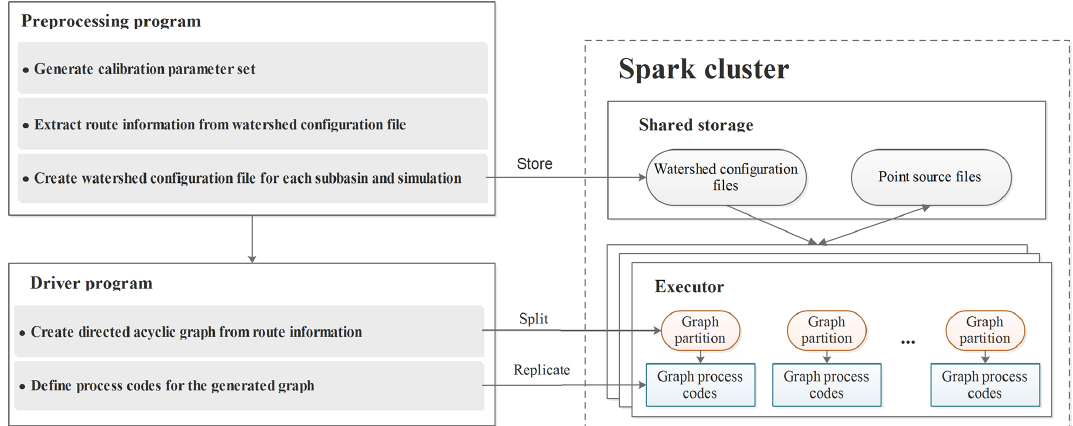
Figure 2. Schematic diagram of